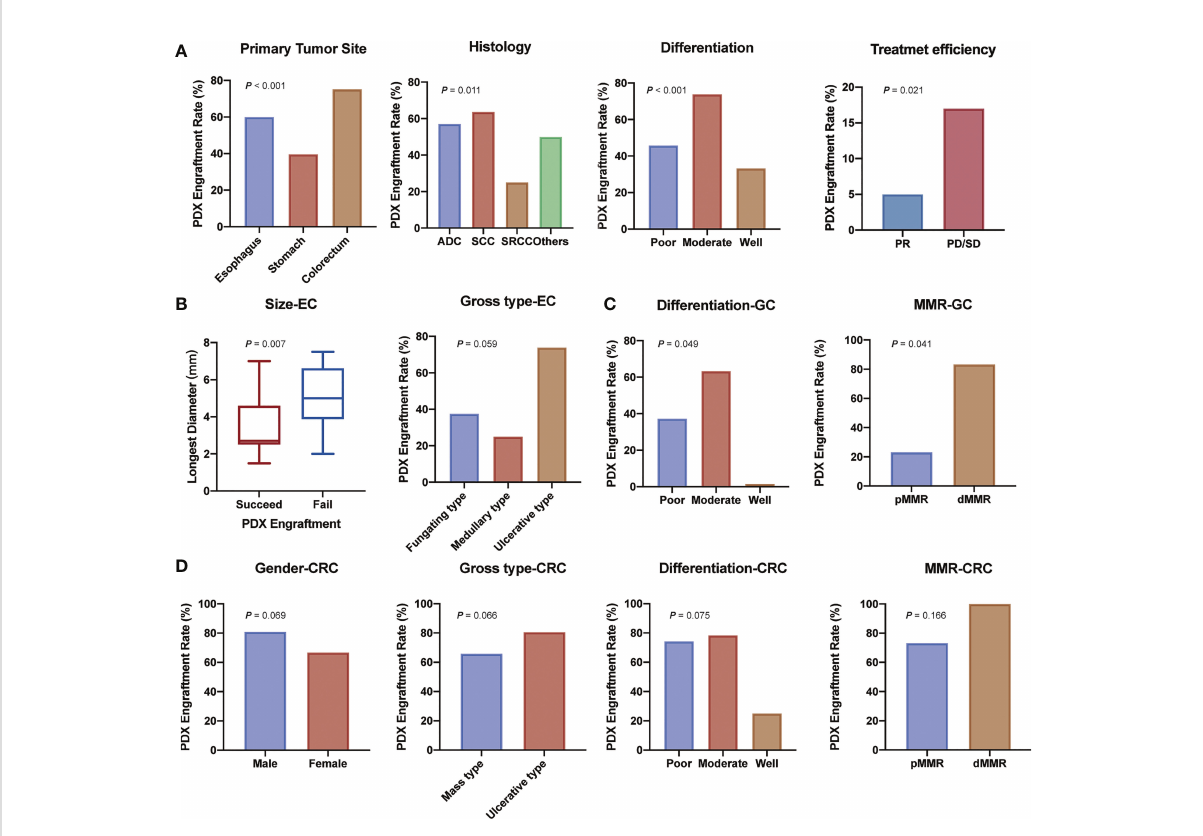
FIGURE 2 Demographic and clinical parameters associated with engraftment of gastrointestinal tract cancer patient-derived xenografts. (A) Clinicopathological factors related to PDX establishment. (B) Clinicopathological factors related to esophagus cancer PDX establishment. (C) Clinicopathological factors related to gastric cancer PDX establishment. (D) Clinicopathological factors related to colorectal cancer PDX establishment. (ADC, adenocarcinoma; SCC, squamous cell carcinoma; SRCC, signet ring cell carcinoma; PR, partial response; PD/SD, progressive disease or stable disease; EC, esophagus cancer; GC, gastric cancer; CRC, colorectal